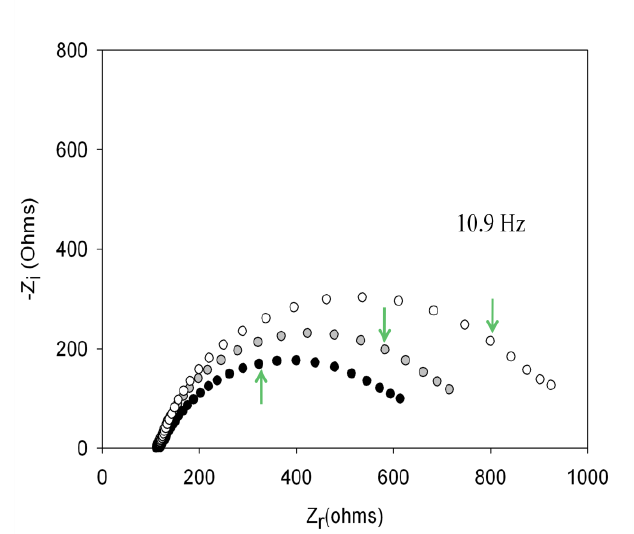
Figure 5. Nyquist Diagram of: ( a ) Electrode-buffer ●, ( b ) Aptamer of thrombin (AptThr) ●, and ( c ) AptThr-Thr ○ 10 pM [Thr]. The arrow in each spectrum denotes the frequency (AC) of 10.9